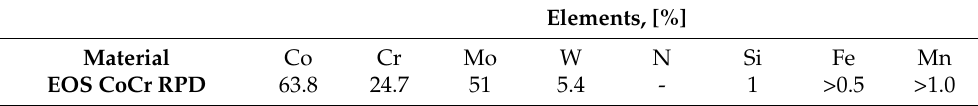
Table 1. Chemical composition of tested